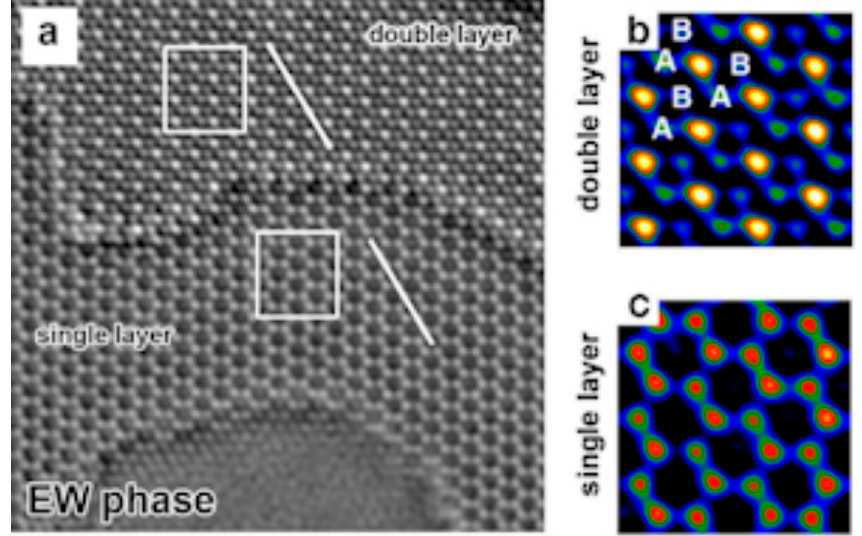
Figure 12. ( a ) Exit wave function (EW) reconstruction TEM image of single and bilayer graphene sheets; ( b , c ) Higher magnification colourised images from parts of single and bilayer regions. Reproduced with permission from [94]. Elsevier, 2011.